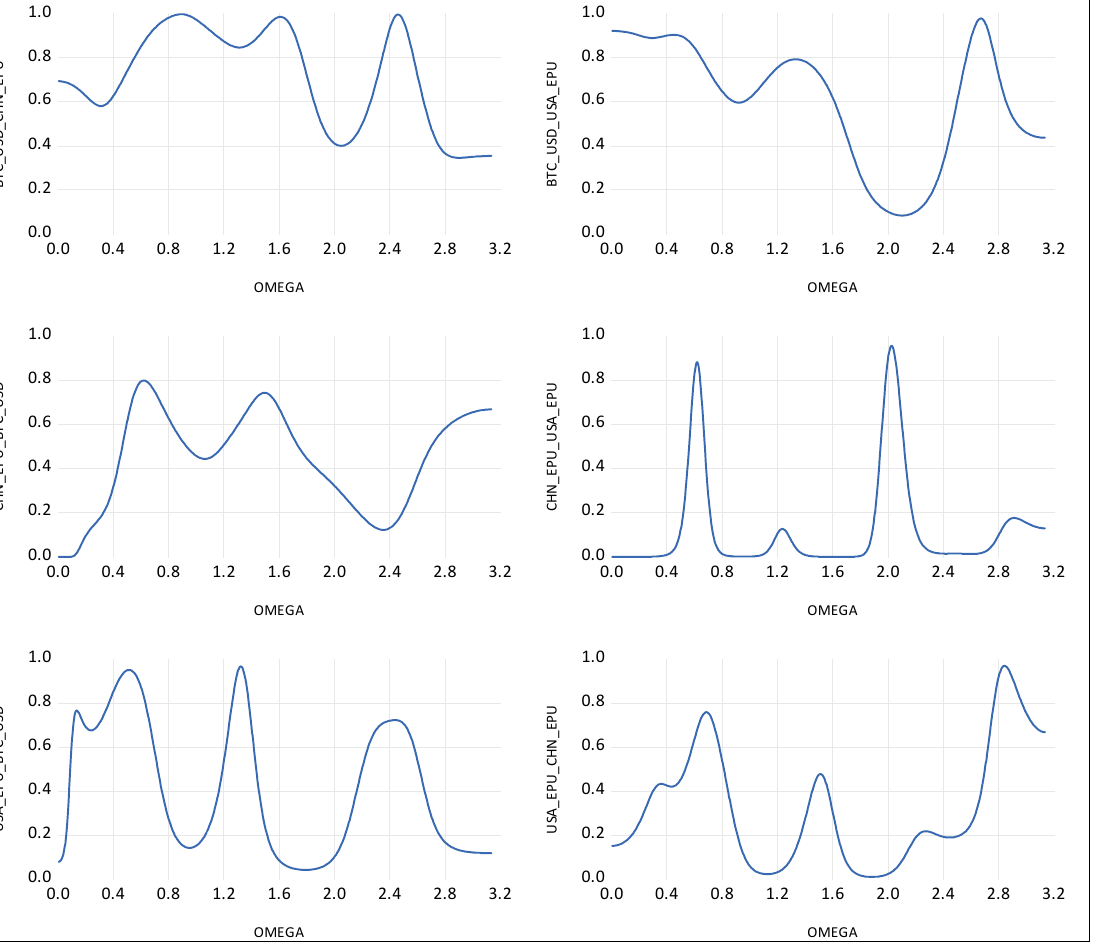
Figure 4. Breitung and Candelon’s (2006) Granger causality test. Notes: (i) BTC = Bitcoin; CHN_EPU = Chinese economic policy uncertainty index; USA_EPU = USA economic policy uncertainty index.